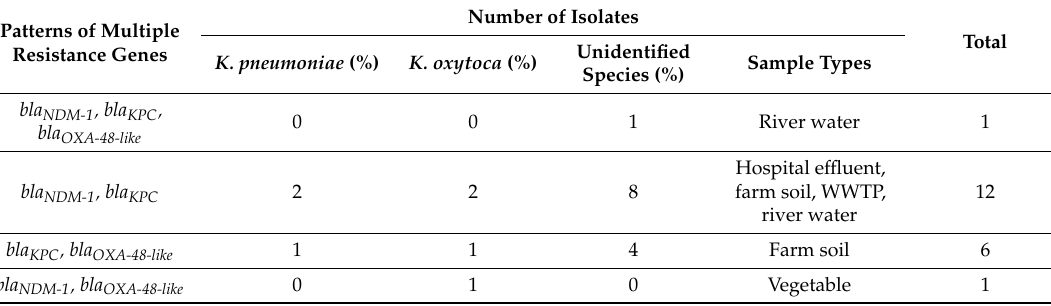
Table 5. Distribution of multiple carbapenem-resistance genes identified among the isolates. Patterns of Multiple Resistance